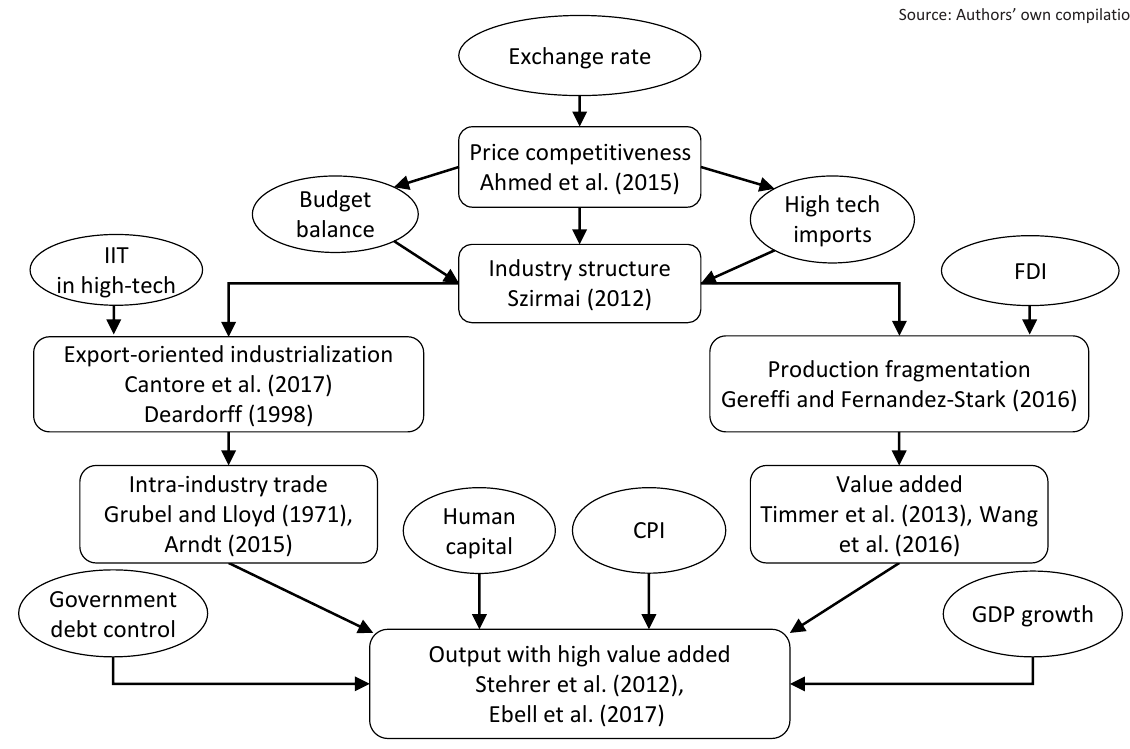
Figure 1. Theoretical framework of the research: the main predicted